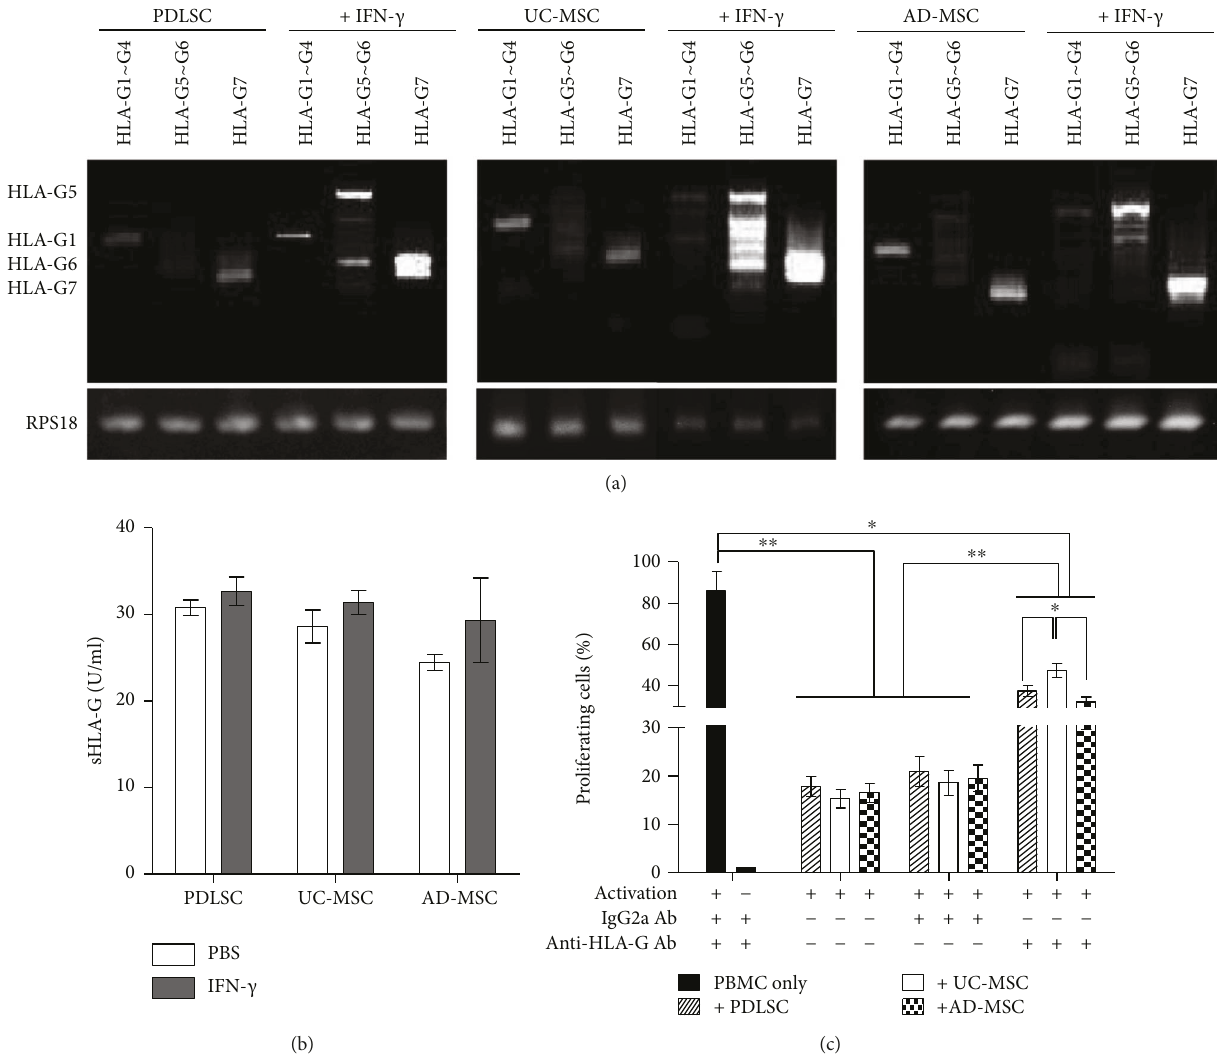
Figure 5: Expression of HLA-G following IFN- γ treatment. (a) RNAs were extracted from PDLSCs, UC-MSCs, and AD-MSCs prior to and following activation with 10 ng/mL IFN- γ for 24 hours, and RT-PCR analysis of the HLA-G subtypes was performed. The primers used are listed in Table 1. Ribosomal protein S18 (RPS18) was used as a reference gene. This experiment was performed three times, and a representative fi gure is shown. (b) Culture supernatants of each MSC, treated or nontreated with 10 ng/mL for 48 hours, were harvested and subjected for secretory HLA-Gs by ELISA. Samples were from three independent experiments and were duplicated. No statistical di ff erence was observed among groups. (c) Inhibitory role of HLA-G on activated T-cell proliferation. A T-cell proliferation assay was performed using CFSE-loaded PBMCs. Cells were activated with anti-CD3 and anti-CD28 beads and cocultured with UC-MSCs, AD- MSCs, or PDLSCs at an MSC:PBMC ratio of 1:10 in the presence of PBS, neutralizing anti-HLA-G antibody (anti-HLA-G Ab), or isotype control antibody (IgG2a). All experiments were performed independently at least three times. The fi gure shows a graph depicting the means and SEMs for the experiments. Flow cytometric pro fi les are presented in Supplementary Figure